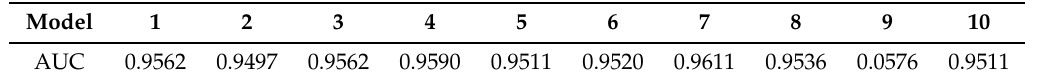
Figure 5. Sample receiver operating characteristic (ROC) curve for Model 7 (with area under the curve (AUC) 0.9611. Table 4. Leave-one-out cross validation (LOOCV) ROC areas under the curve.